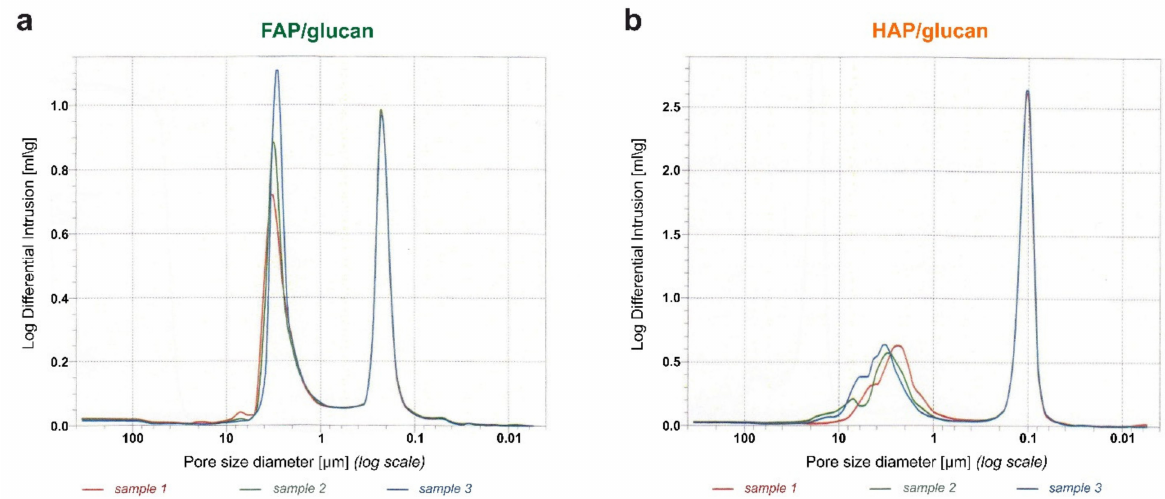
Figure 3. Pore size distribution expressed by the log-differential intrusion volumes (presented on logarithmic scales) for the FAP/glucan ( a ) and HAP/glucan ( b ) composites. Table 1. Selected parameters of porosity of FAP/glucan and HAP/glucan composites.